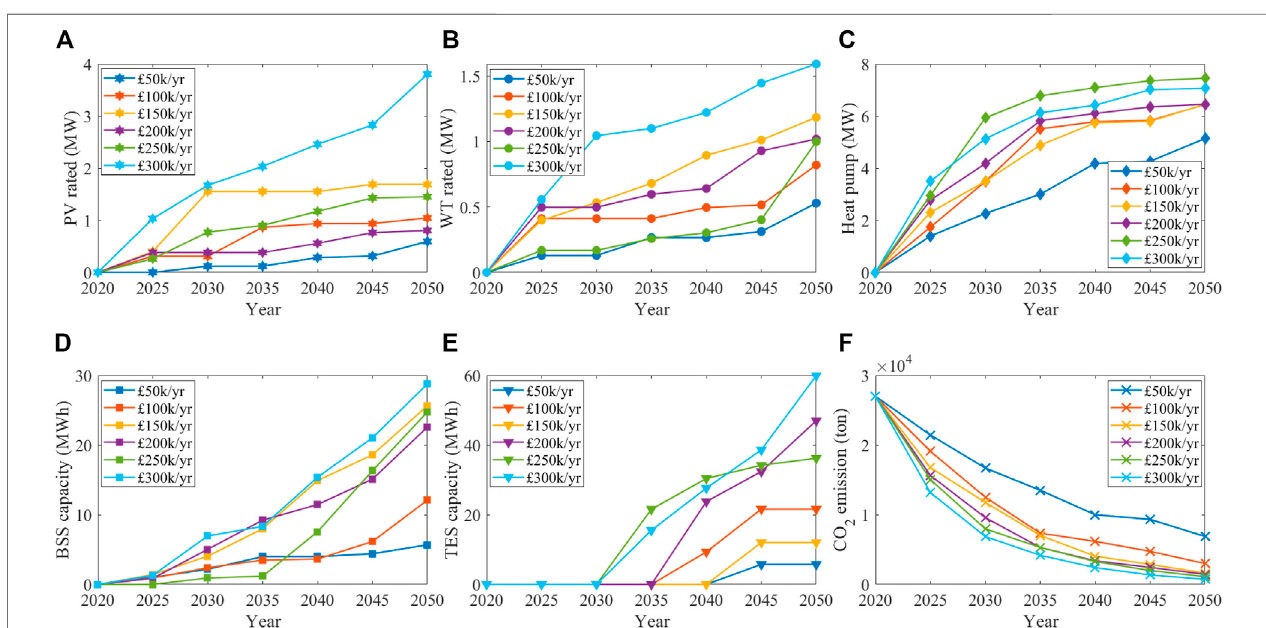
FIGURE 7 | Optimisation result of installing renewable energy, heat pump and BSS, and the reduction of CO 2 emission.